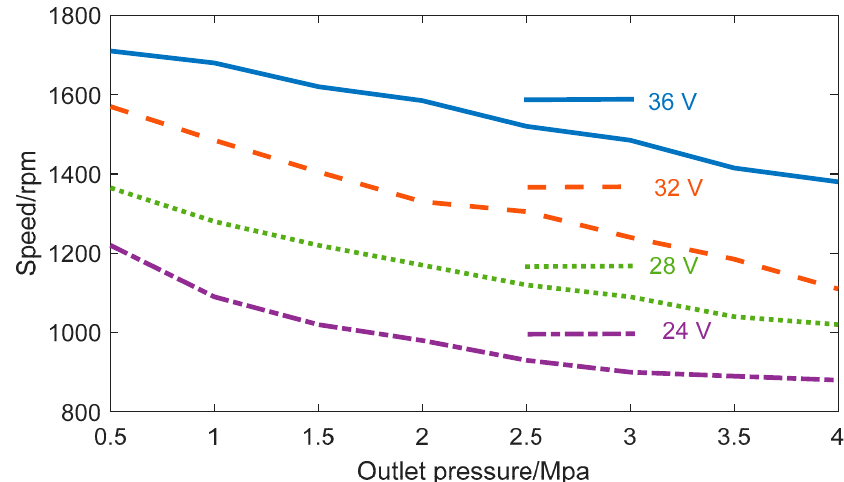
Figure 11. The influence of outlet pressure on motor speed.